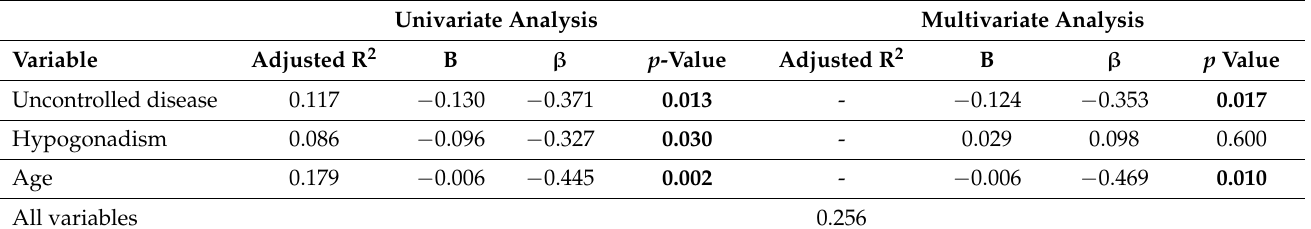
Legend to Table 4: B, unstandardized B; β , standardized coefficient β . Bold text indicates statistical significance ( p -value less than